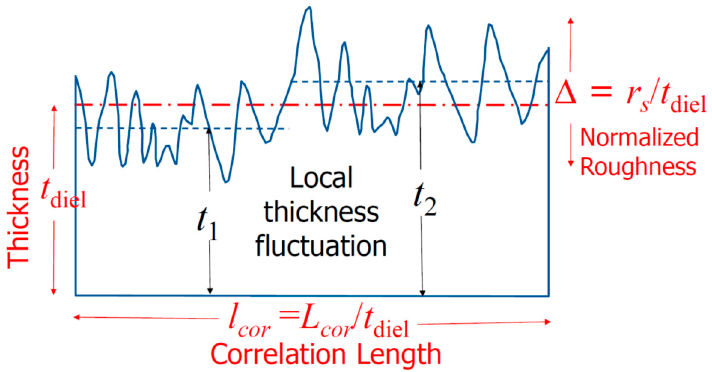
Figure 3. Definitions of key roughness parameters and illustration of local averaged thickness vari- ation for small-sized devices as a function of the applied field.